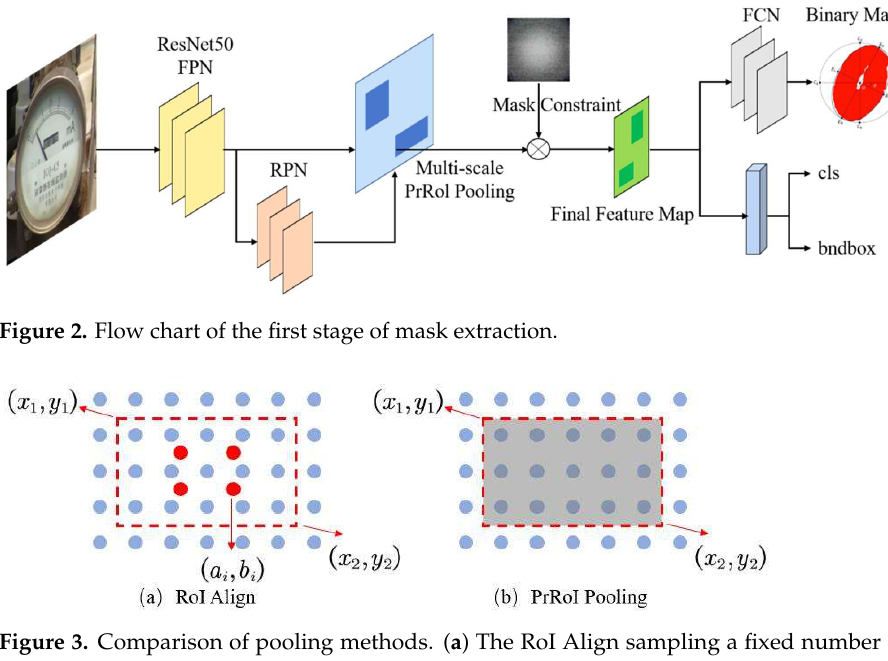
Figure 3. Comparison of pooling methods. ( a ) The RoI Align sampling a fixed number of points. ( b ) The PrRoI Pooling using a fully integrated averaging pool.